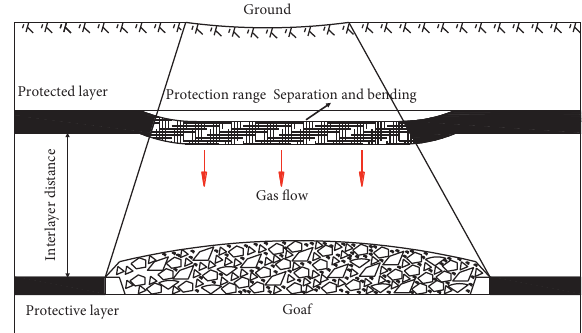
Figure 1: The schematic diagram for protective layer